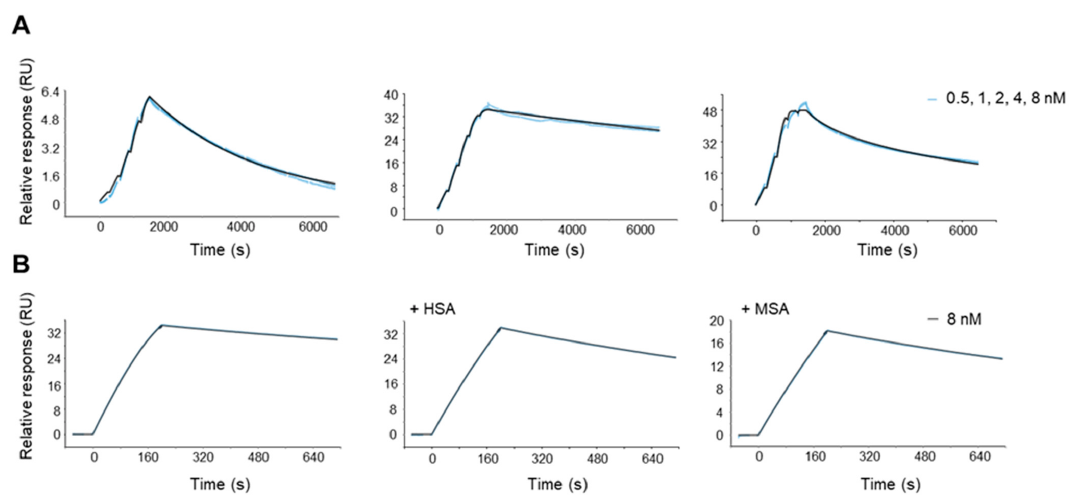
Figure 3. ( A ) Single-cycle kinetics SPR sensorgrams showing PEP40233 concentration series (0.5, 1, 2, 4, 8 nM) interaction curve with, from left to right, immobilized Her2, HSA, and MSA. ( B ) A-B-A injection sensorgrams showing PEP40233 (8 nM) binding to HER2 in the presence of HSA/MSA. The data confirm binding to HER2 both in presence and absence of albumin. Table 1. Kinetic parameters of PEP40233 interacting with HER2, HSA and MSA.